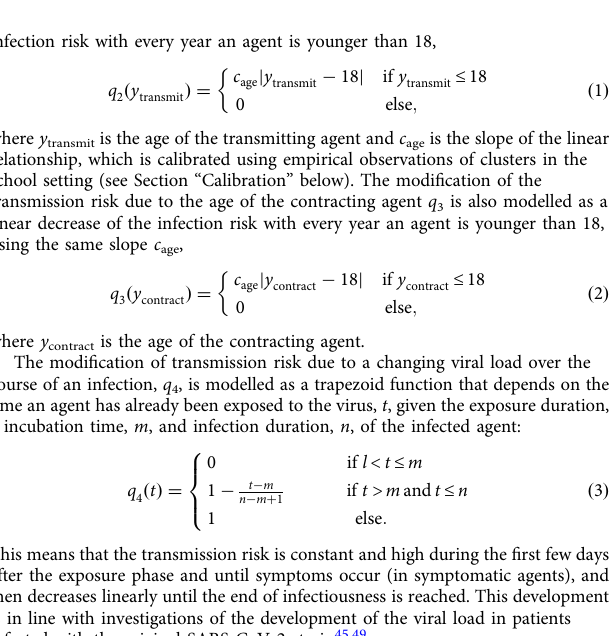
Fig. 7 Distributions of parameters used in the agent based simulation. A Exposure duration, l , ( B ) incubation time, m , and ( C ) infection duration,